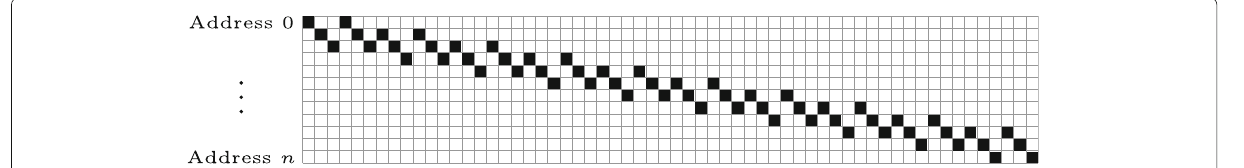
Fig. 1 The access pattern to the eviction set. Addresses 0 to n map to the same cache